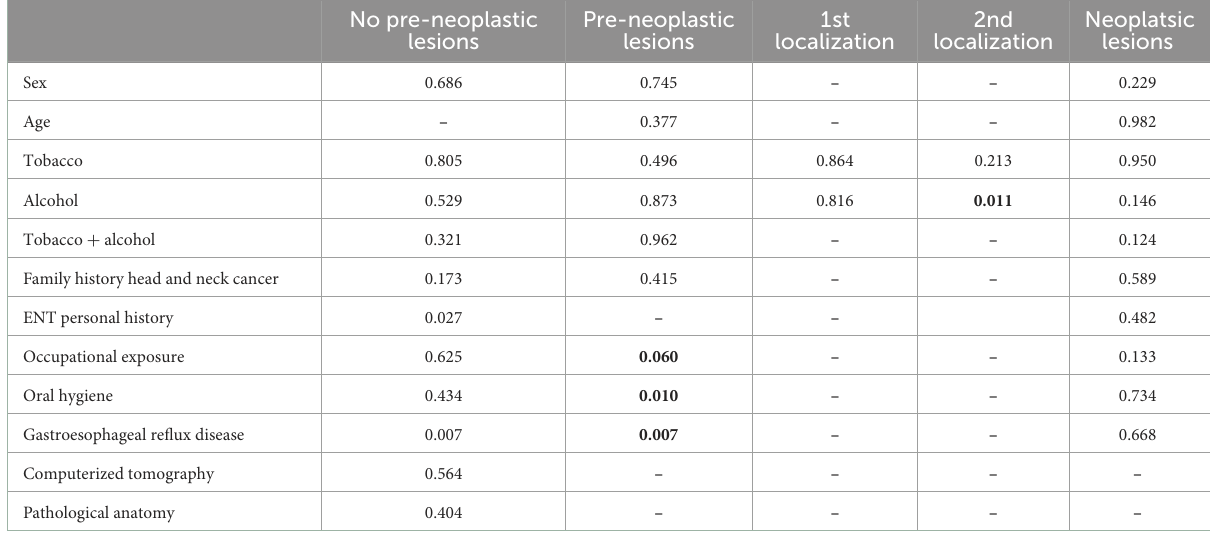
TABLE 1 Statistical correlations between the detection of lesions and the information collected in the anamnesis or in the examination. No pre-neoplastic